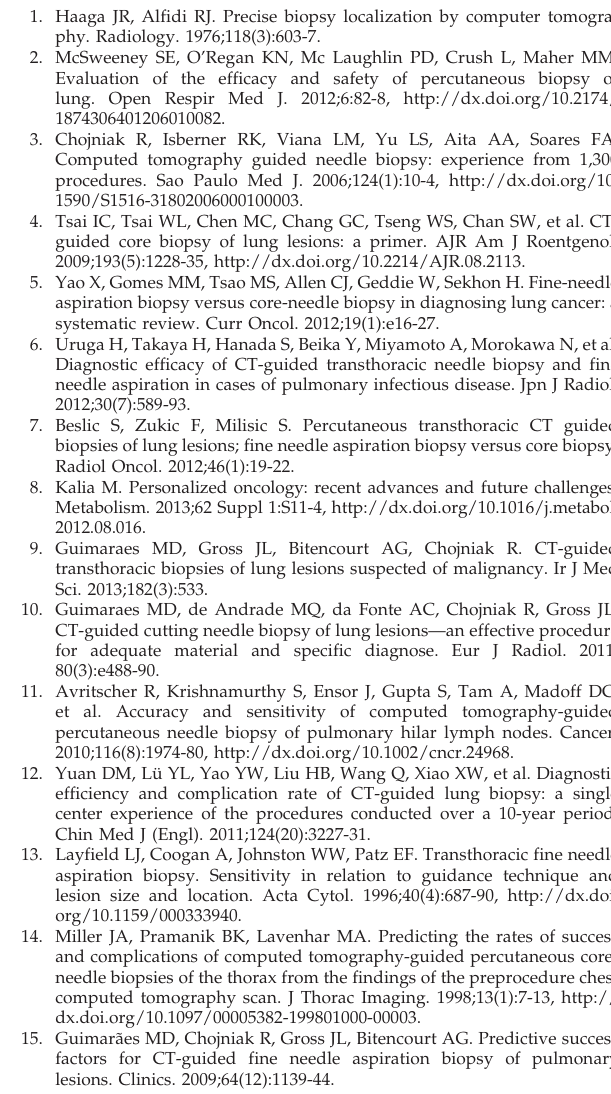
FNAB, fine-needle aspiration biopsy; n, number of lung